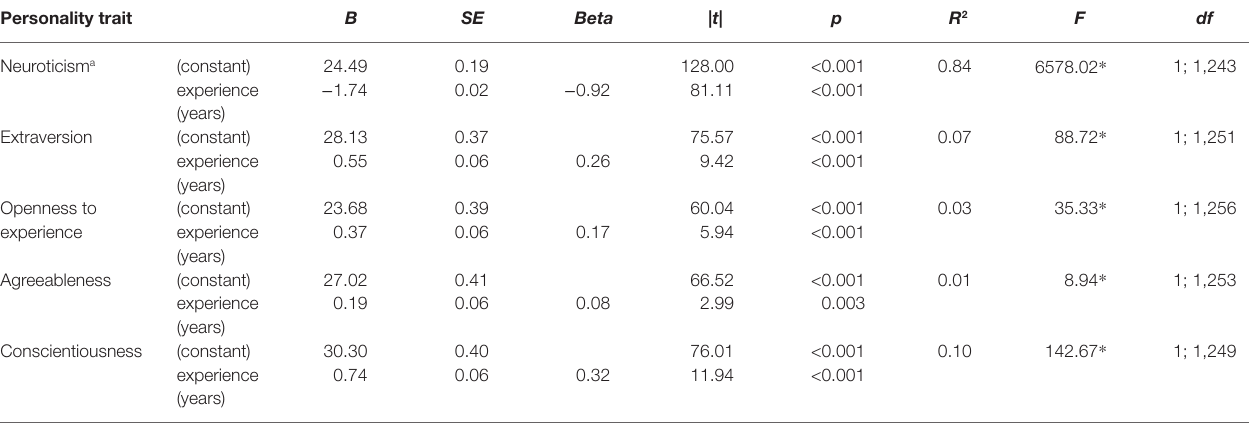
TABLE 3 | Coefficients of linear regression models predicting individual personality traits based on sports experience in years. Personality trait B SE